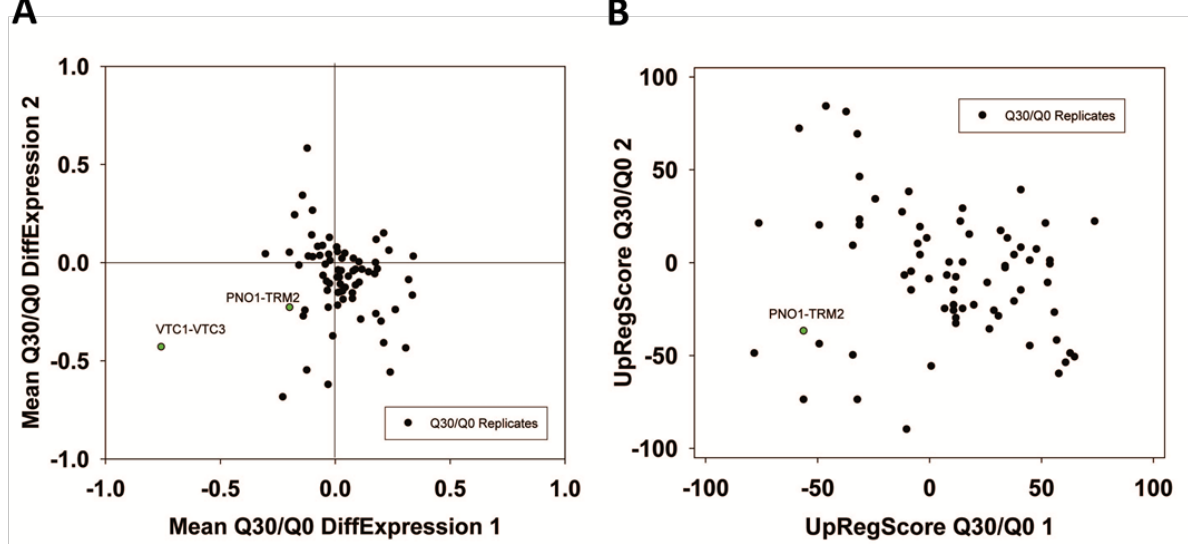
FIGURE 6: Analysis of non-toxic effects of polyglutamine expression with pQ30. (A) Correlation based on the expression differences and (B) the UpRegScore with the cliques being labelled, if significantly shifted in the same direction in both